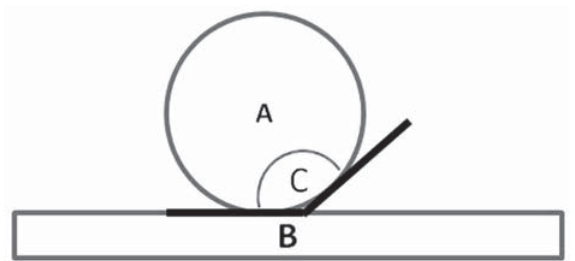
Figure 1- The WCA diagram. This image is representative of the silanized group for observing the obtained hydrophobic characteristics of the intra-radicular dentin surface. A: water drop, B: intra-radicular dentin, C: contact angle Table 1- The mean values of contact angles (Mean±SD)